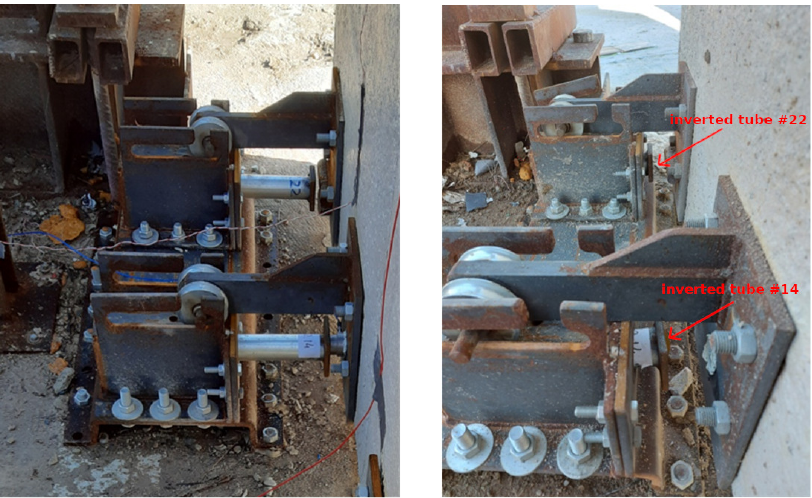
Figure 10. Sample panel 4A— φ 42 × 1.5 mm tubes: before blast ( left ) and after blast test ( right